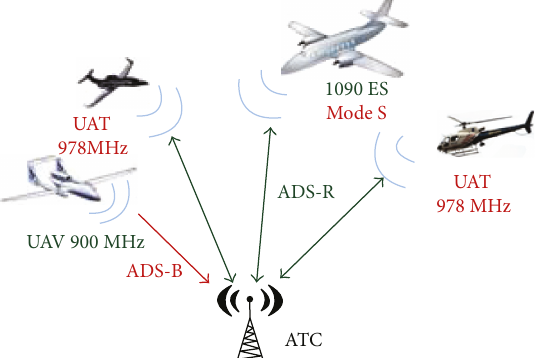
Figure 2: ADS-R for broad surveillance